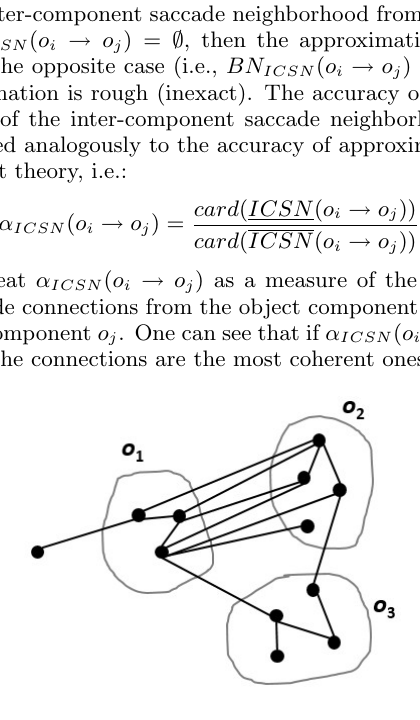
Figure 3: An example of the the fragment of a com- plex network over the visual stimulus By replacing the standard set inclusion with the major- ity set inclusion in the original definitions of the lower and upper approximations of the inter-component saccade neigh- borhood, from o i to o j , we obtain the generalized notions of the β -lower and β -upper approximations, respectively.